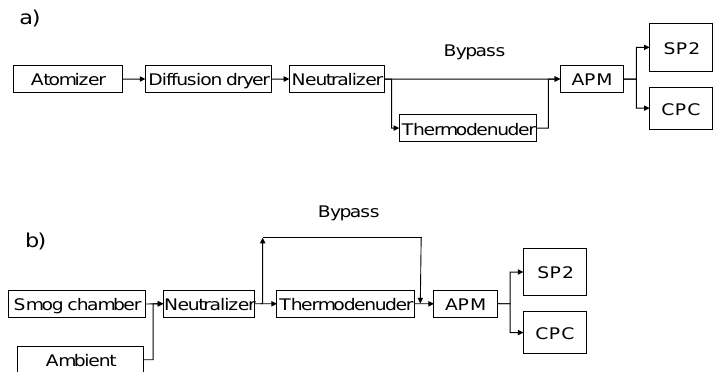
Fig. 3. Experimental setup for SP2 calibration using (a) an aqueous suspension of BC or (b) BC particles from the smog chamber/ambient